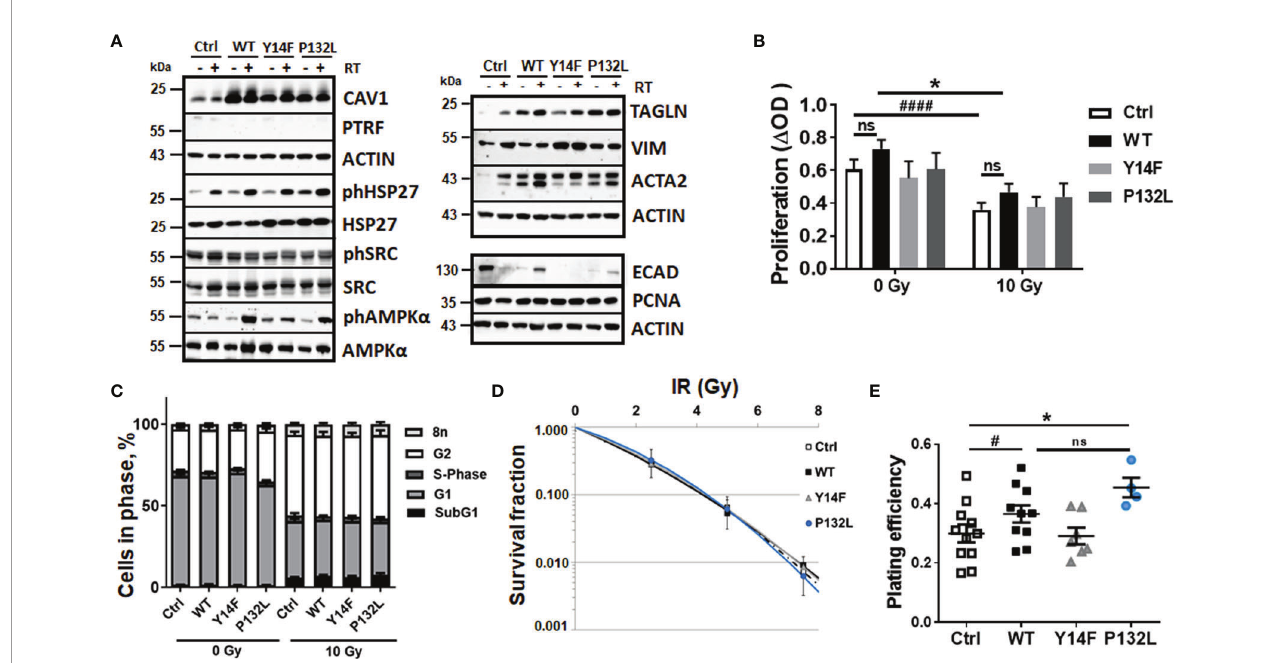
FIGURE 1 | CAV1-dependent increases in AMP-activated protein kinase (AMPK)-mediated signaling accompanied by EMT phenotypes in LNCaP PCa cells. Expression levels of the indicated proteins were analyzed in whole protein lysates of cultured LNCaP PCa cells stably overexpressing the introduced CAV1 variants (wildtype CAV1, WT; phosphorylation-de fi cient CAV1, Y14F; the transmembrane localization affecting proline-132-to-leucine substituted CAV1, P132L) with or without radiation treatment (48 h after RT with 10 Gy) using Western blot analysis. Empty vector transduced LNCaP cells with low endogenous CAV1 levels served as controls [Ctrl (CAV-)]. (A) Representative blots from at least 4 independent experiments are shown. (B) Cell proliferation was determined using crystal violet staining. Data are summarized as mean values ± SEM of 6 – 13 independent experiments measured in quadruplets each. P-values indicate: *p ≤ 0.05 by one-way ANOVA with Tukey ’ s multiple comparison post- test and additionally by unpaired (two-tailed) t-tests depicted as #### p ≤ 0.001. (C) Cell cycle phases and apoptotic cells (subG1) were analyzed by fl ow cytometry. Graphs consist of data from 12 – 15 individual experiments (with SEM). The statistically signi fi cant differences within SubG1 (p ≤ 0.001), G1 (p ≤ 0.001), and G2 (p ≤ 0.001) values as estimated by two-way ANOVA with Tukey ’ s multiple comparison test (0 Gy versus 10 Gy for each CAV1 variant) were not depicted. (D) Clonogenic survival was evaluated 10 days post treatment. Coomassie stained colonies were quanti fi ed by counting. Data show the surviving fractions from at least 3 independent experiments (means ± SD) plated in triplicates each. (E) Plating ef fi ciency was determined after 10 days following plating of low cell numbers (500 cells per 35 mm dish, plated in triplicates each). Symbols depict individual values from different independent experiments. P-value indicates: *p ≤ 0.05 by one-way ANOVA with Tukey ’ s multiple comparison post-test and additionally by unpaired (two-tailed) t-test depicted as # p ≤ 0.05. ns, not signi fi